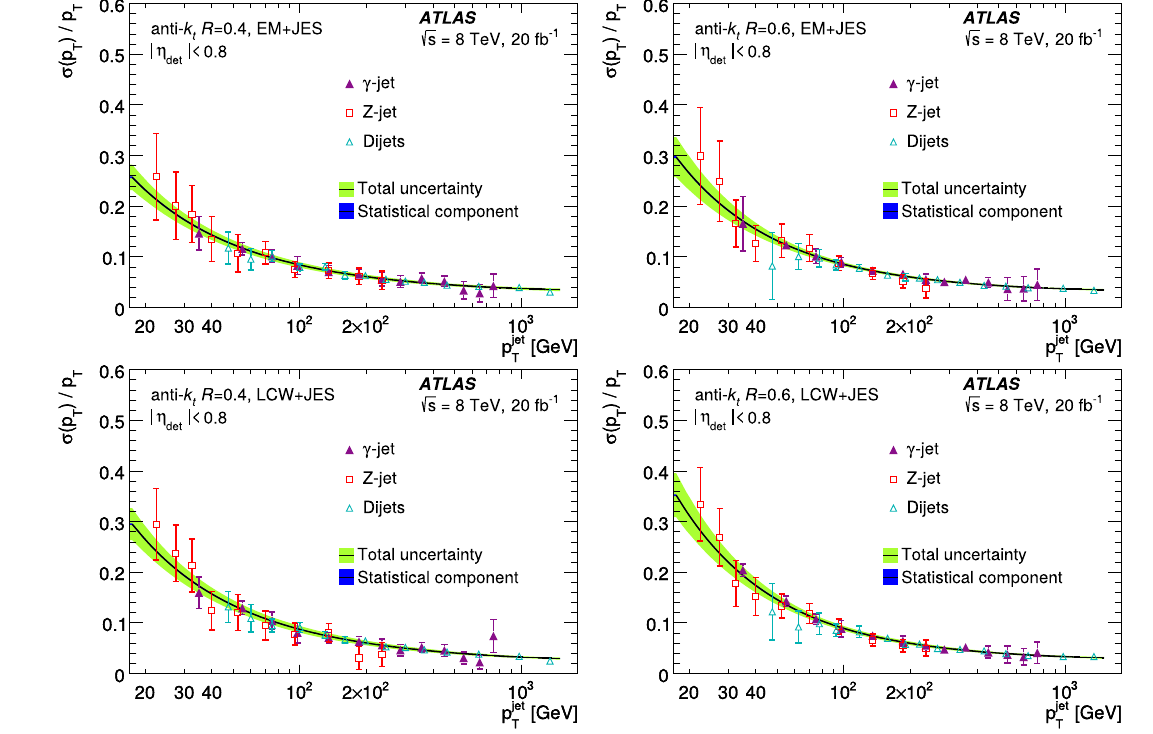
Fig. 57 The jet resolution as a function of p T for the four different jet collections in the central region. The three in situ inputs to the measure- ment, namely Z +jet (empty squares), γ +jet (filled triangles), and dijet